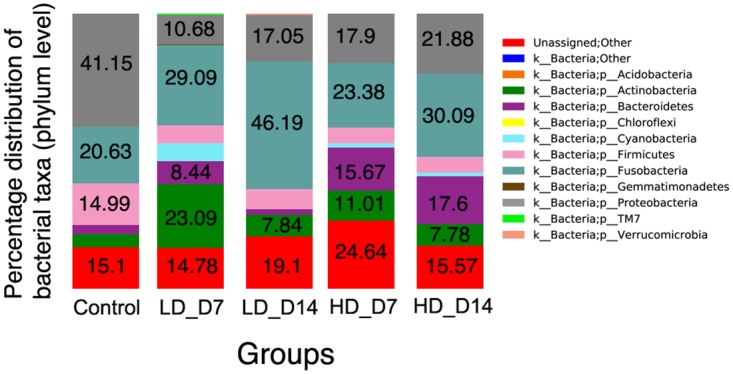
Bacterial community composition of Atlantic salmon skin in each experimental group.Bar chart of the mean relative abundance of phyla present in the salmon skin from the five different experimental groups. LD_D7: low-dose infected day 7; LD_D14: low-dose infected day 14; HD_D7: high-dose infected day 7; HD_D14: high-dose infected day 14. Number represent the relative percentage of each phyla that had abundances greater than 7.6%.